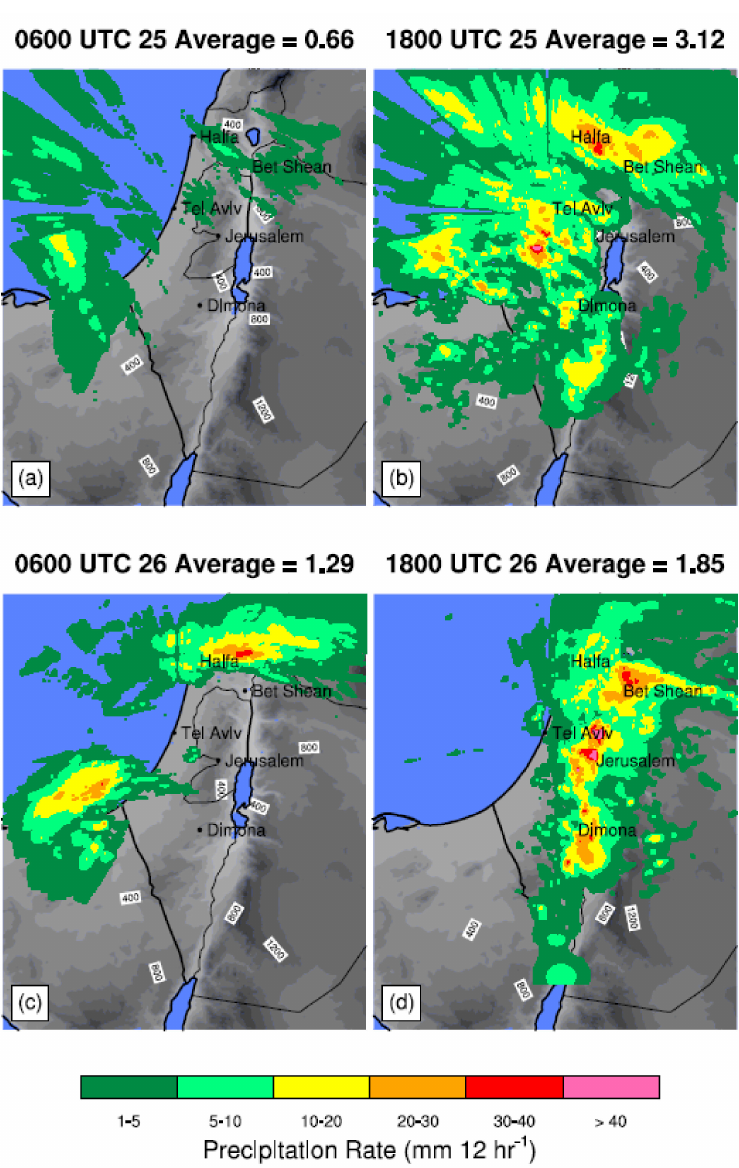
Figure 5. Derived rainfall rates from observed radar reflectivity for the 12 h periods ending at the ( a ) 0600 UTC 25 April, ( b ) 1800 UTC 25 April, ( c ) 0600 UTC 26 April, and ( d ) 1800 UTC 26 April 2018. The domain averages are also shown in the panel